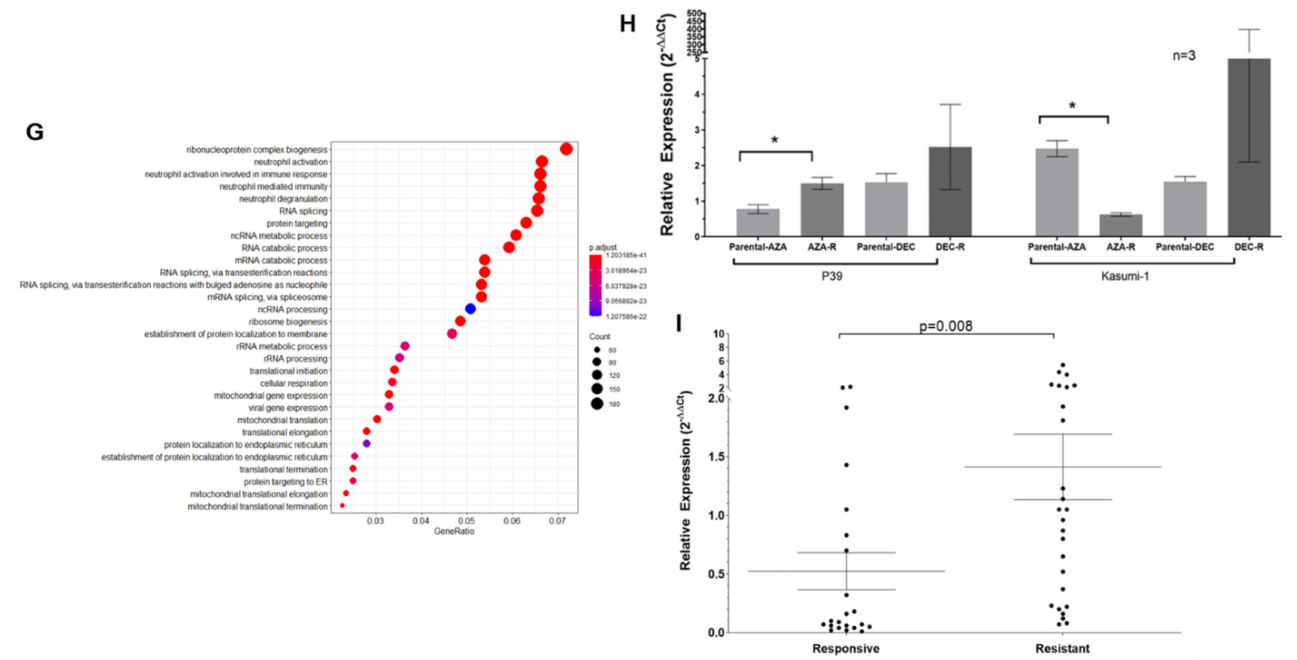
Figure 4. Association of PTEN and MDM2 methylation with mRNA expression. ( A ) Downregulation of PTEN by quantitative polymerase chain reaction (Q-PCR) in azacitidine and decitabine resistant cell lines; ( B ) Validation of PTEN DNA methylation in patients responsive or resistant to hypomethylating agents using pyrosequencing. Individual CpG methylation levels were displayed as individual data points with red data points (red dots) being the same loci (cg10041390) detected to be hypermethylated in 850k whole methylome microarray. The total number of dots denotes the number of CpG sites evaluated, where red dots d enote CpG sites with methylation changes and black dots denote flanking or additional CpG sites; ( C ) Downregulation of PTEN by Q-PCR in patients with myelodysplastic resistant to hypomethylating agents; ( D ) Expression of MDM2 in cell lines sensitive and resistant to azacitidine and decitabine; ( E ) Validation of MDM2 hypomethylation in patients with MDS resistant to hypomethylating agents by pyrosequencing. Individual CpG methylation levels were displayed as individual data points, with red data points (red dots) being the same loci (cg00614420) detected to be hypomethylated in 850k whole methylome microarray. The total number of dots denotes the number of CpG sites evaluated, where red dots denote CpG sites with methylation changes and black dots denote flanking or additional CpG sites; ( F ) Expression of MDM2 in patients with MDS responsive and resistant to hypomethylating agents; ( G ) Epi-transcriptomic profiling of P39 and azacitidine-resistant P39 (P39-AZA-R) cell line. Direct RNA sequencing of P39 cells and P39-AZA-R detected 5,340,619 differential methylated transcripts including the MDM2 processed